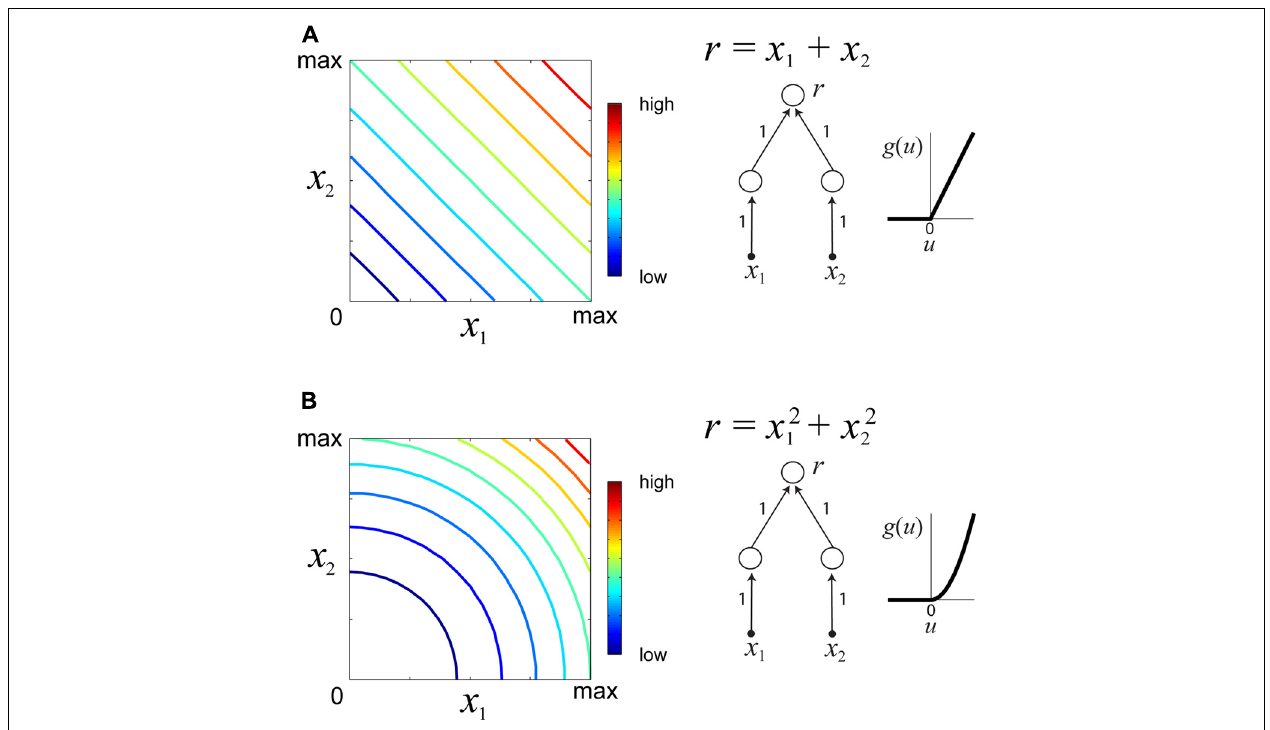
FIGURE 3 | Examples of iso-responses surfaces for two hypothetical sensory processing models. (A) Iso-response contours (left) of a sensory neuron which linearly integrates stimulus variables x 1 , x 2 ≥ 0.The response r of this neuron is a summation of the outputs of two neurons in the lower